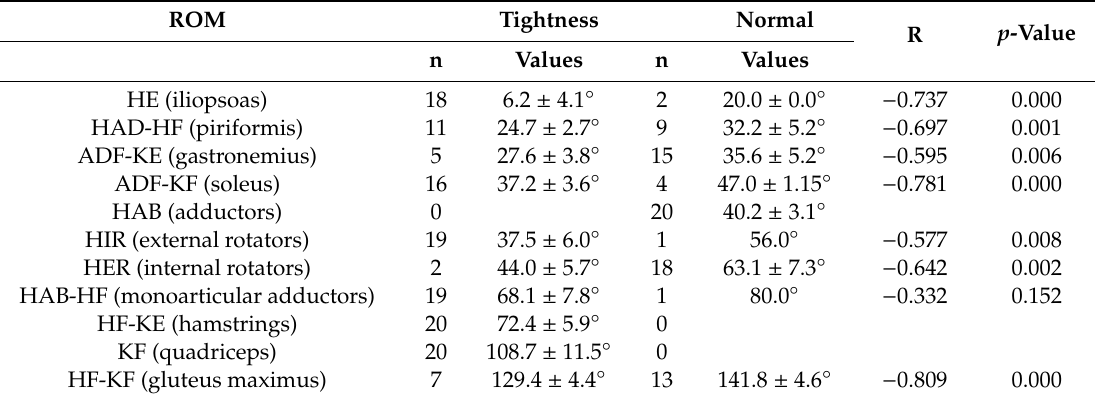
Table 5. Classification of a range of motion values (normal versus tightness) of the dominant limb in the 20 inline hockey players of the Spanish elite male and female national teams.